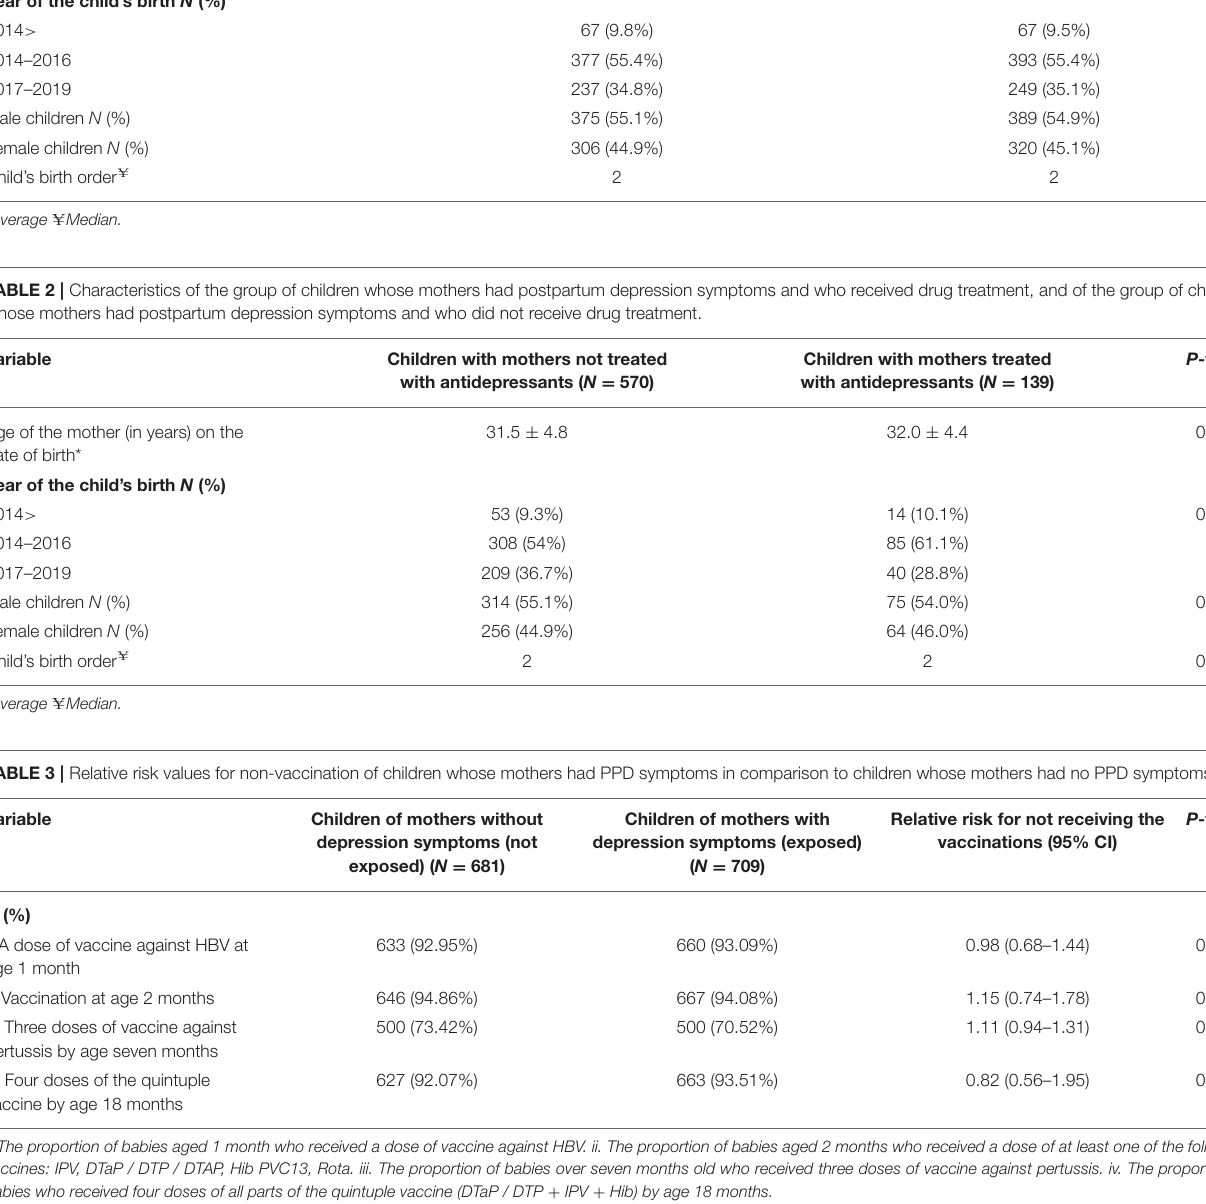
TABLE 1 | Characteristics of the group of children whose mothers had postpartum depression symptoms and the group of children whose mothers had no postpartum depression symptoms. Variable